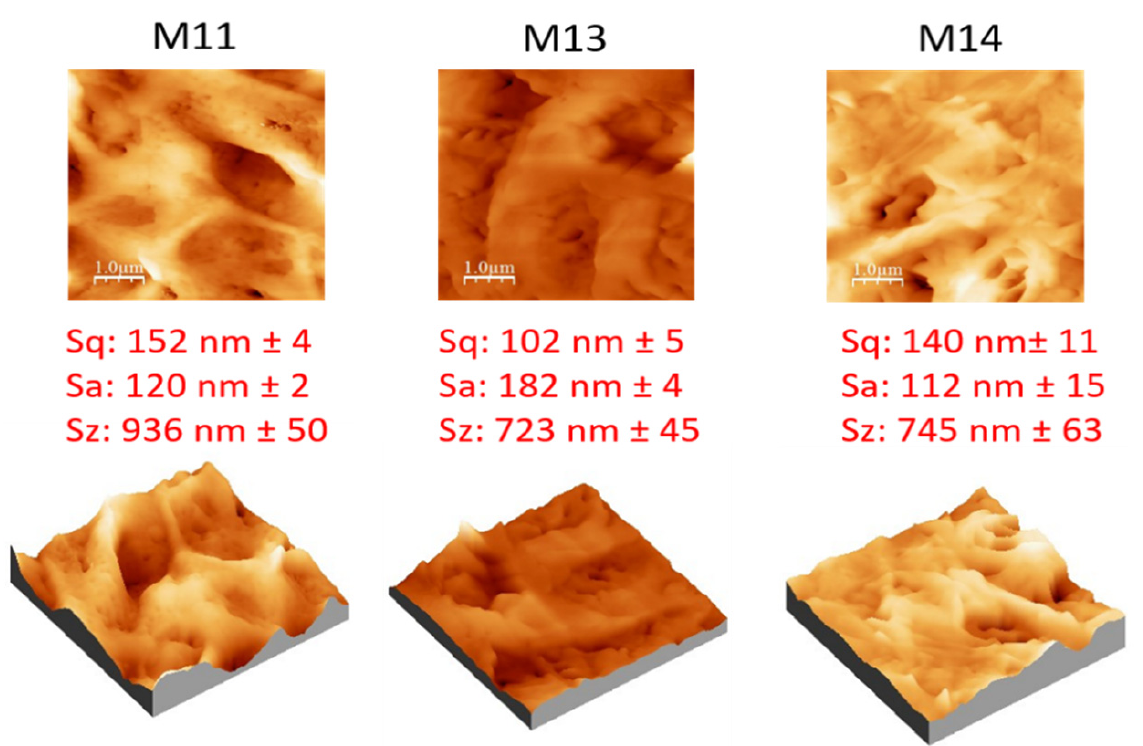
Figure 12. AFM images, with corresponding 3D views, and roughness parameters of M11, M13 and M14 membranes.